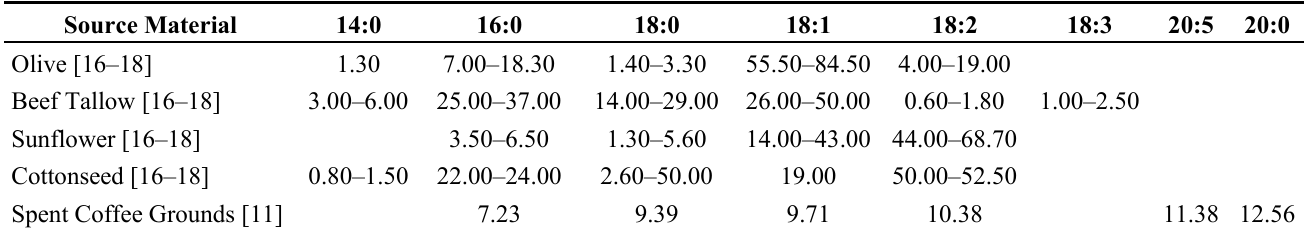
Table 1. Composition of Biodiesel Obtained from Different